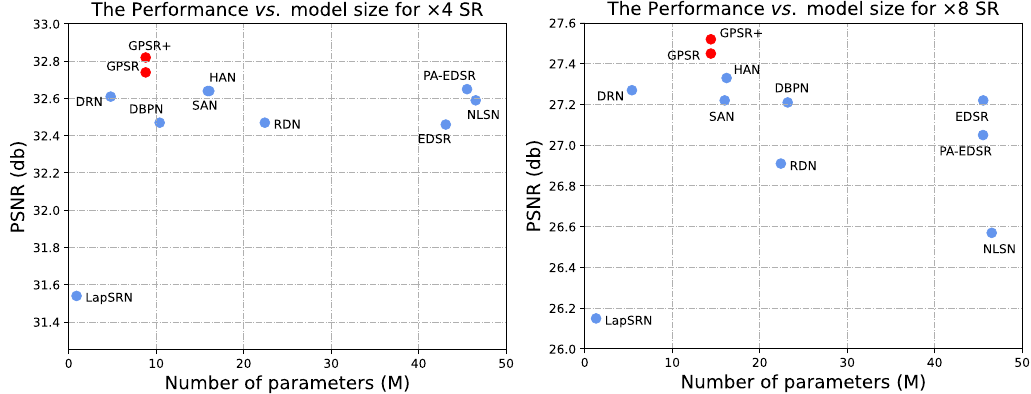
Figure 8. Comparisons of the PSNR metric and the number of parameters among different SR models on the Set5